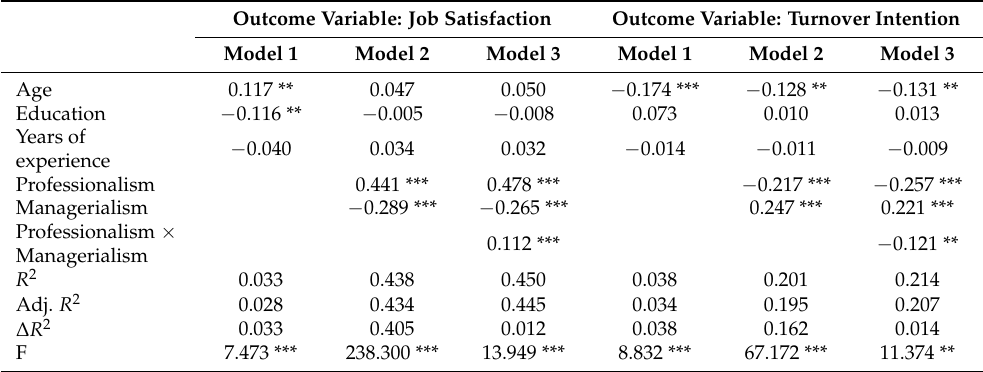
Table 3. Moderated mediating model test ( n =